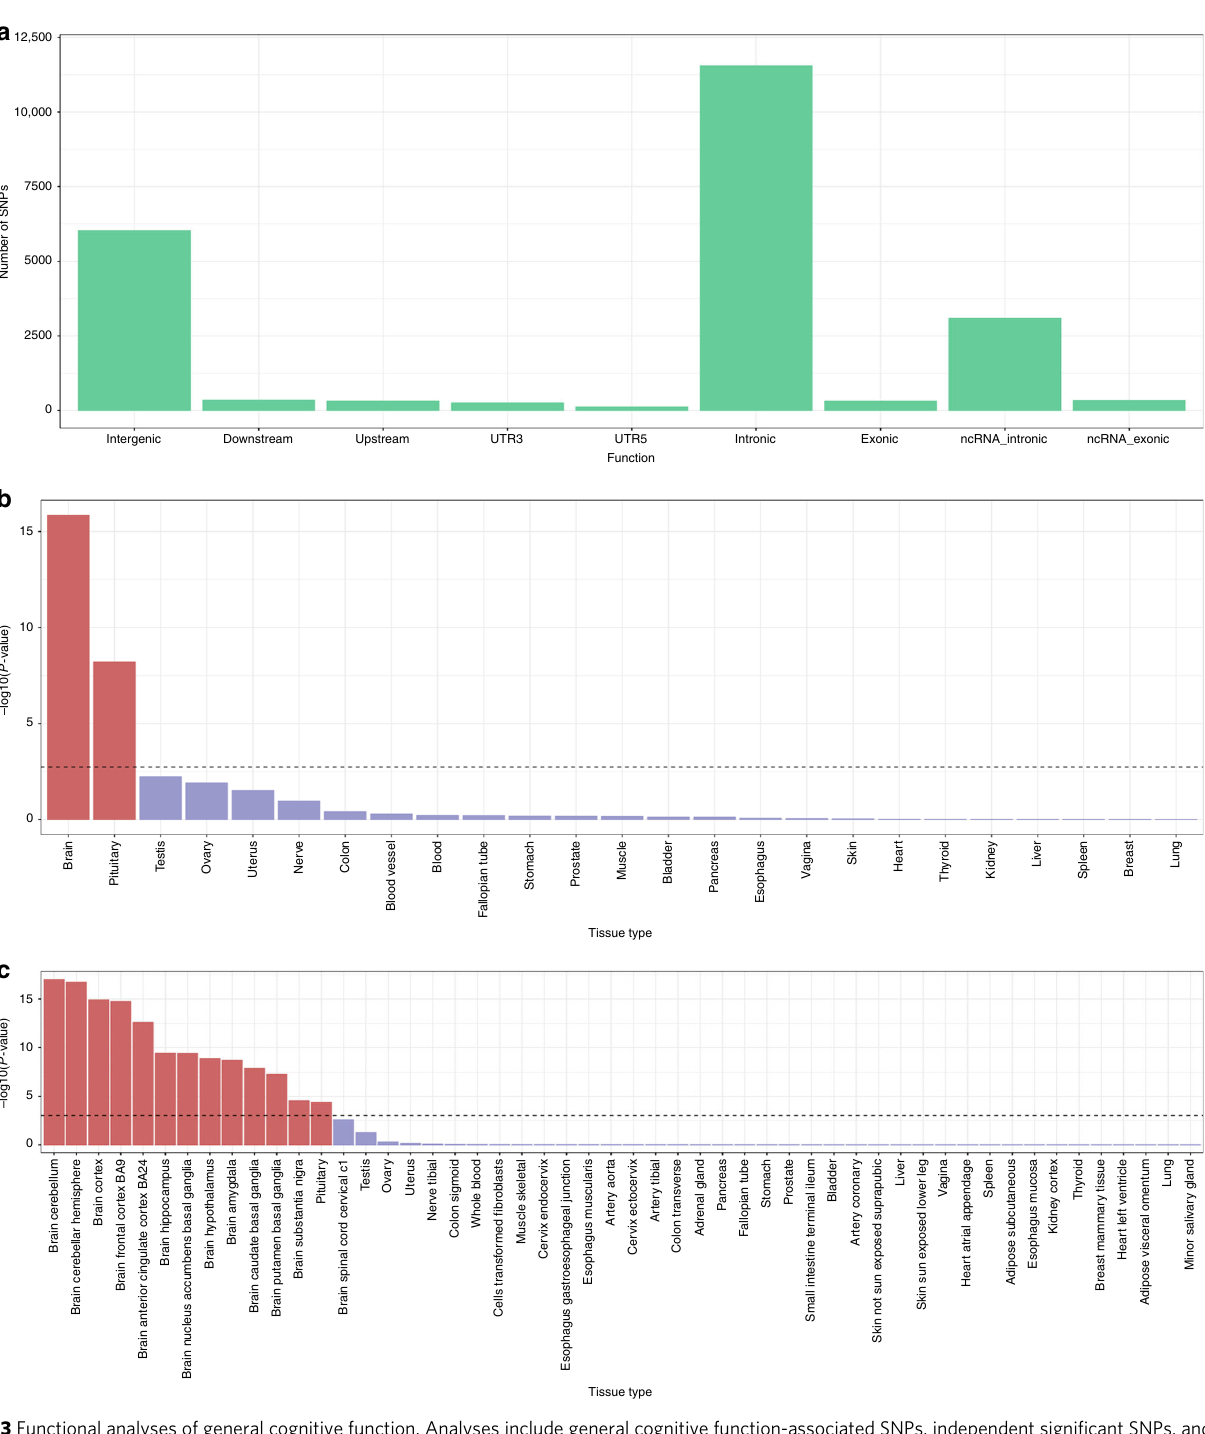
Fig. 3 Functional analyses of general cognitive function. Analyses include general cognitive function-associated SNPs, independent signi fi cant SNPs, and all SNPs in LD with independent signi fi cant SNPs. Functional consequences of SNPs on genes ( a ) indicated by functional annotation assigned by ANNOVAR. MAGMA gene-property analysis results; results are shown for average expression of 30 general tissue types ( b ) and 53 speci fi c tissue types ( c ). The dotted line indicates the Bonferroni-corrected α of the larger cohorts: ELSA, Generation Scotland, and Under- We tested the genetic correlations between general cognitive standing Society. The polygenic pro fi le score for general cognitive function and 52 health-related traits. Thirty-six of these health- function explained 2.63% of the variance in ELSA ( β = 0.17, related traits were signi fi cantly genetically correlated with − 51 ), 3.73% in Generation Scotland SE = 0.01, P = 1.70 × 10 general cognitive function (Supplementary Data 9). We report ( β = 0.20, SE = 0.01, P = 5.02 × 10 − 68 ), and 4.31% in Under- signi fi cant genetic correlations between general cognitive − 88 standing Society ( β = 0.22, SE = 0.01, P = 6.17 × 10 ). Full function and: hypertension ( r g = − 0.15, SE = 0.02), grip strength results for all fi ve thresholds are shown in Supplementary Table 2. (right hand: r g = 0.09, SE = 0.02), wearing glasses or